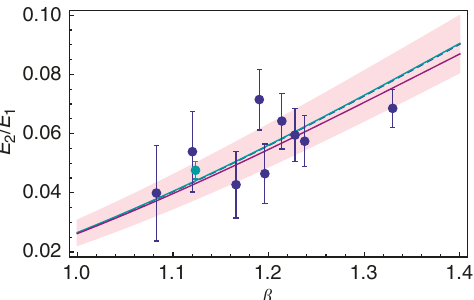
Fig. 6 Comparison between the experimentally obtained E 2 / E 1 ratio and the ffiffiffiffiffiffiffiffiffiffiffi p β 2 (cid:2) 1 = 4 . Blue points : the ratio E 2 / E 1 obtained from the universal factor e (cid:2) π = position of the points in Fig. 5. Cyan point: Universal E fi mov energy ratio as measured in Caesium atoms 39, 47 . Blue line ( dashed ): the corresponding ffiffiffiffiffiffiffiffiffiffiffi p β 2 (cid:2) 1 = 4 optimized curve, fi tted according to the model e (cid:2) b = and corresponding to b = 3.145 with standard error of Δ b = 0.06 consistent with the predicted value π . The shaded pink region is the ± 2 Δ b con fi dence interval ffiffiffiffiffiffiffiffiffiffiffi p β 2 (cid:2) 1 = 4 of the curve. Cyan line: universal low-energy factor e (cid:2) π = . Purple line : theoretical ratio E 2 / E 1 obtained from the exact solution of the Dirac equation. As β → 0.5, | E n | becomes smaller therefore the green and purple curves coincide for low β . The error bar on the resonance energies is ±